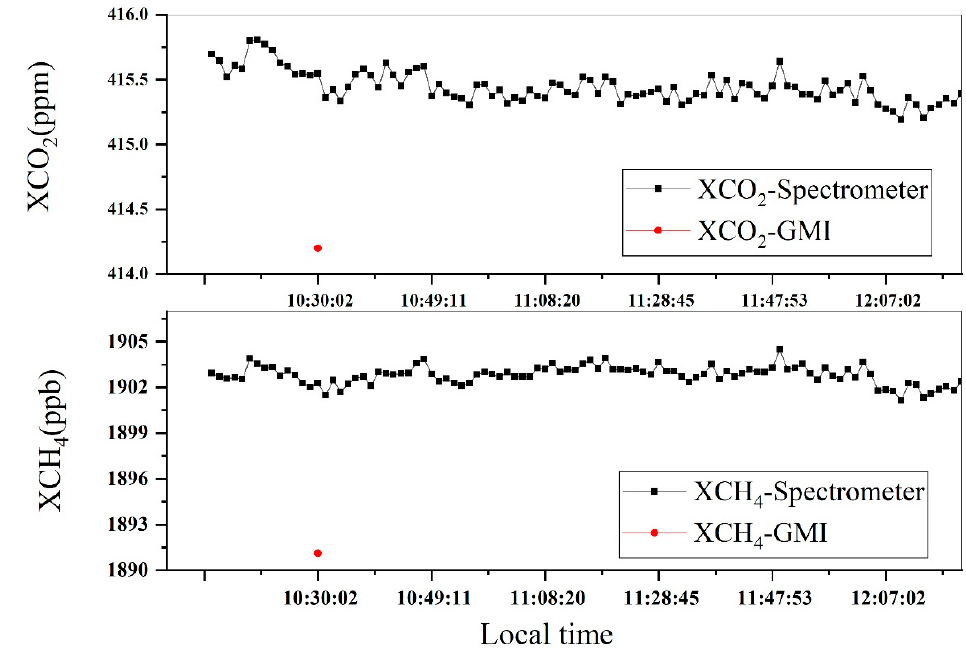
Figure 35. HRFTS and GMI inversion results.